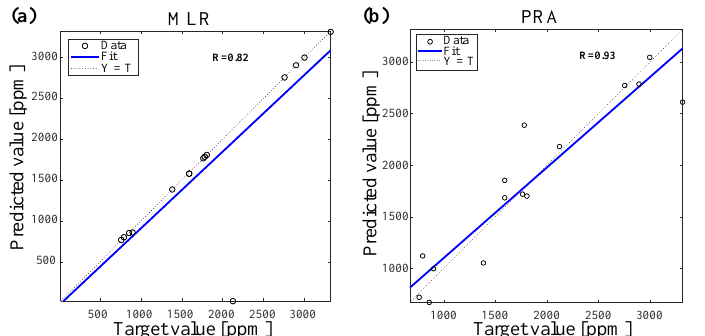
Figure 8. Correlation coefficient between actual and predicted values of nano TiO 2 coated amount after UV treatment by using ( a ) MLR and ( b ) PRA.